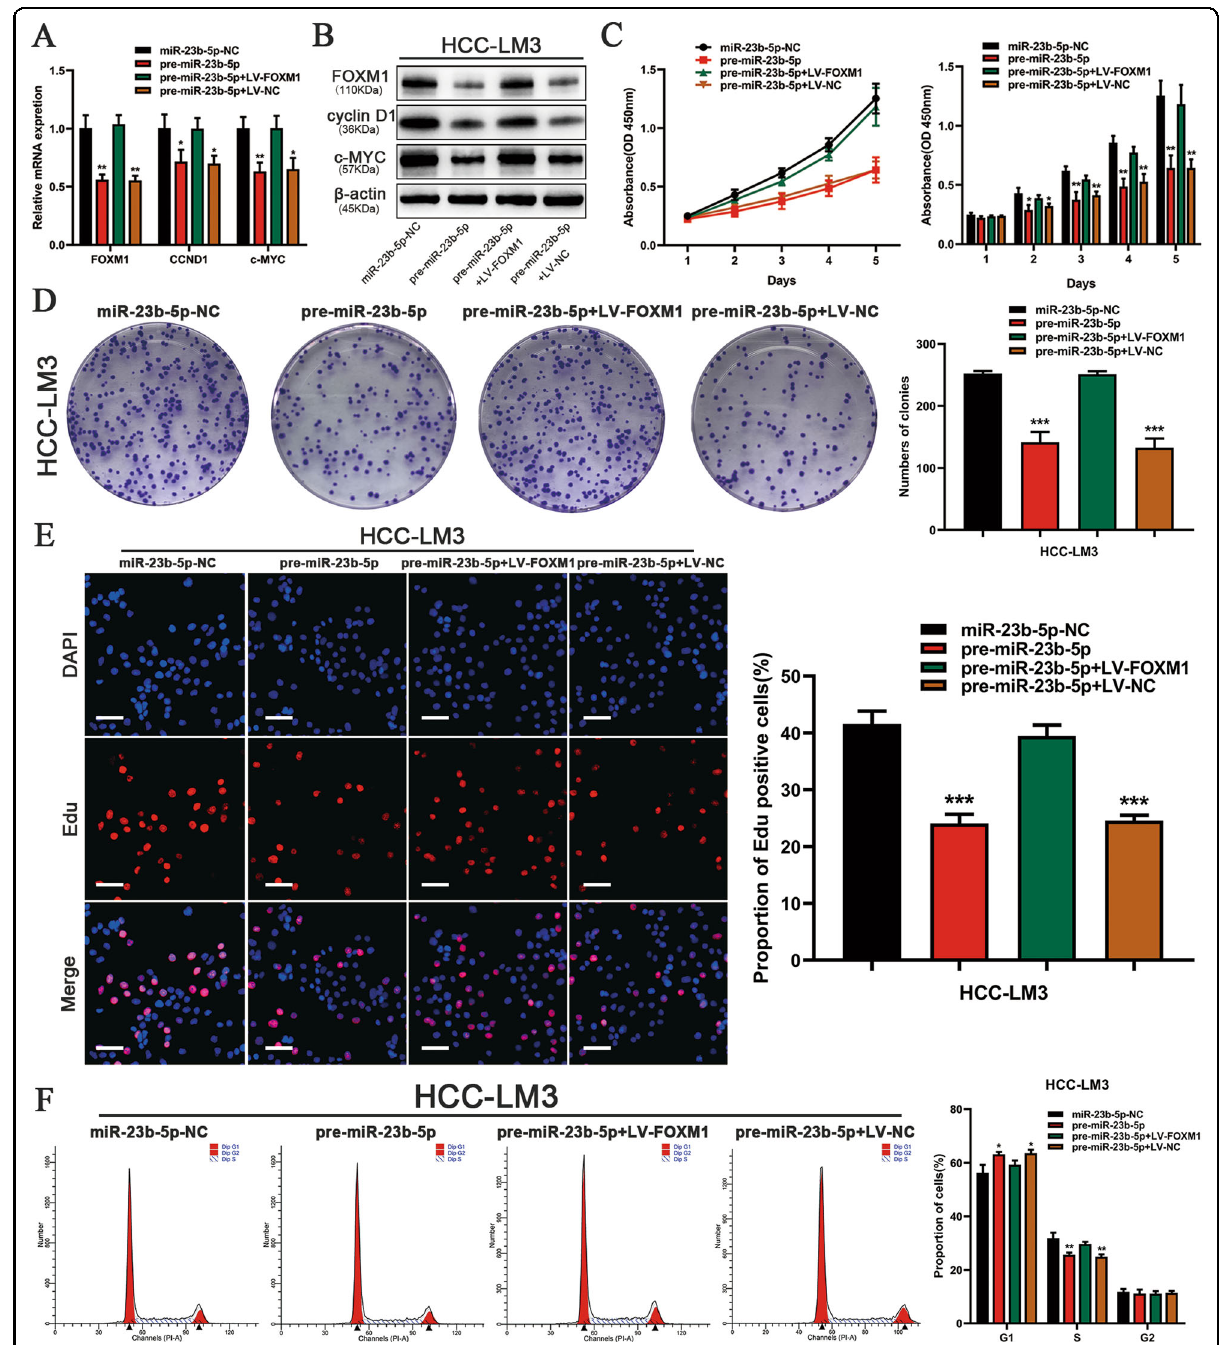
Fig. 4 Restoration of FOXM1 were performed to con fi rm that FOXM1 is the functional target of miR-23b-5p. A , B The expression of FOXM1 and its downstream targets, CCND1 and c-MYC, veri fi ed by qRT PCR and western blot in the HCC-LM3 cells transfected with the miR-23b-5p overexpression lentivirus (pre-miR-23b-5p), FOXM1 overexpression lentivirus (LV-FOXM1) and negative control lentivirus (LV-NC). C CCK-8 assay, D colony formation assay, and E 5-ethynyl-2 ’ -deoxyuridine (EdU) incorporation assay were used to verify the proliferation (scale bars, 50 μ m) and F fl ow cytometry were utilized for cell cycle test of miR-23b-5p-NC, pre-miR-23b-5p, pre-miR-23b-5p plus LV-FOXM1, and pre-miR-23b-5p plus LV-NC in the HCC-LM3 cells. All data are presented as the mean ± S.E.M. (* P < 0.05, ** P < 0.01, and *** P <